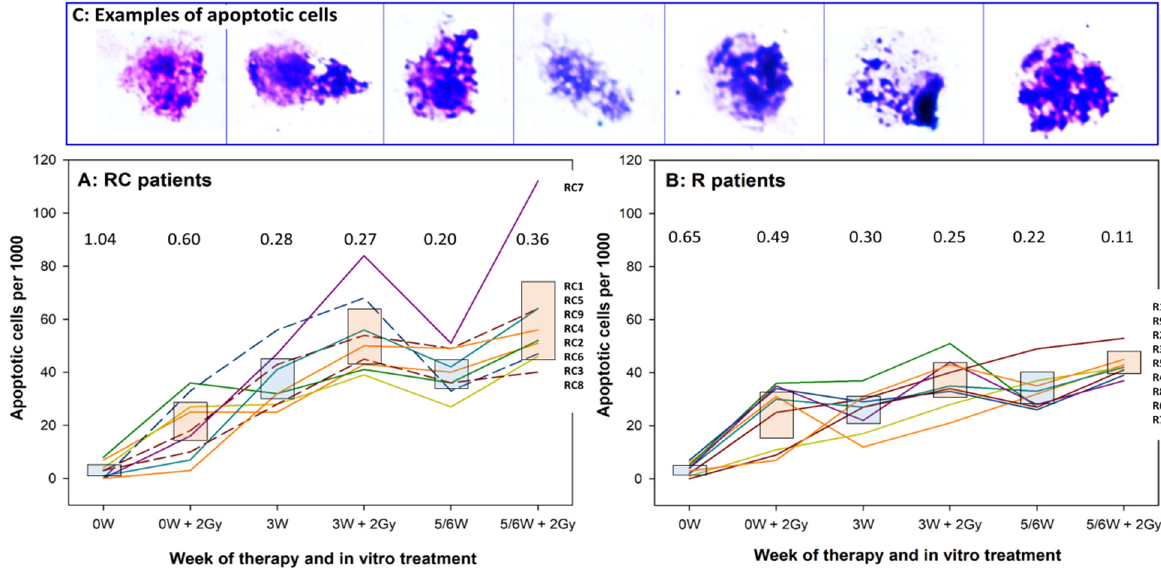
Figure 4. Individual levels of apoptosis in lymphocytes of RC ( A ) and R ( B ) patients. Each line represents a single donor. Lines are shown to facilitate identification of donors and not to represent a time response. Boxes show 95% confidence limits of the respective mean value. Blue boxes: values induced by Therapy alone. Red boxes: values induce by therapy plus 2 Gy ex vivo irradiation. Dashed lines represent patients RC1, RC6 and RC8 who received colony stimulating